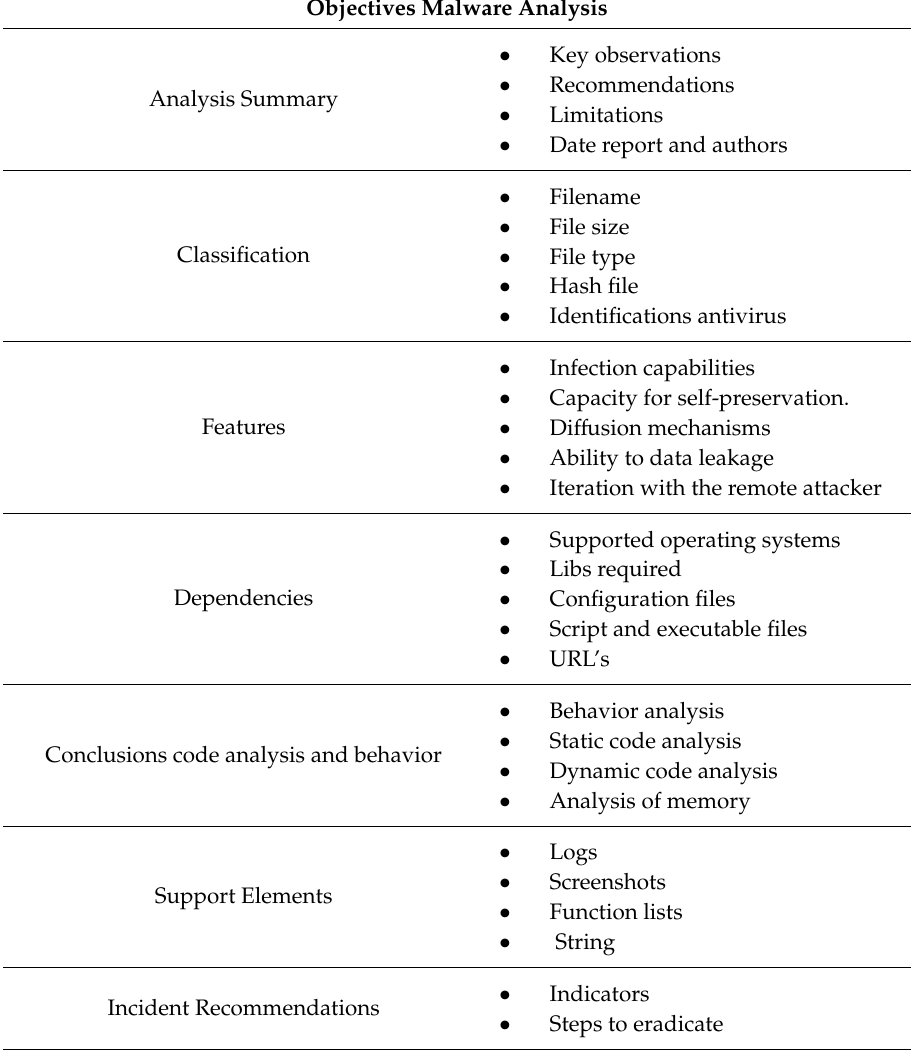
Table 2. Objectives malware analysis methodology. Adapted from REMUX Lenny Zeltser